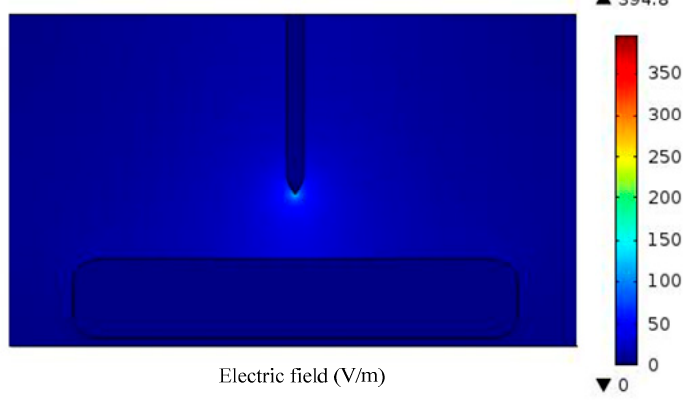
Figure 3. Electric field simulation of needle-plate electrode at 20 mm. 114